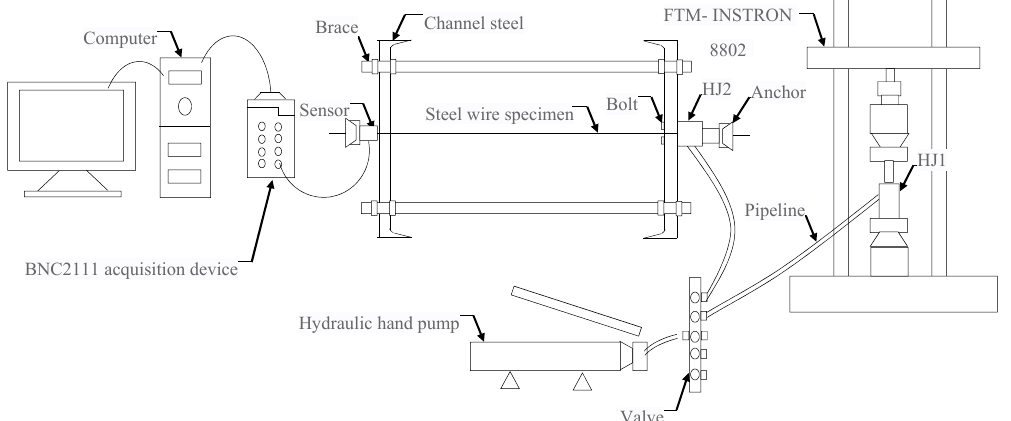
Figure 3. Schematic diagram of loading device.